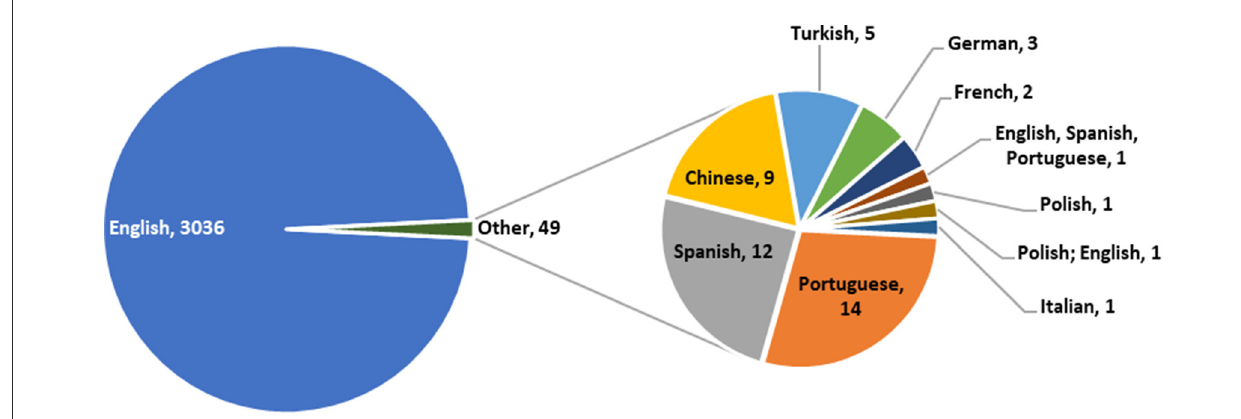
FIGURE5 Adopted languages for SSCM studies.